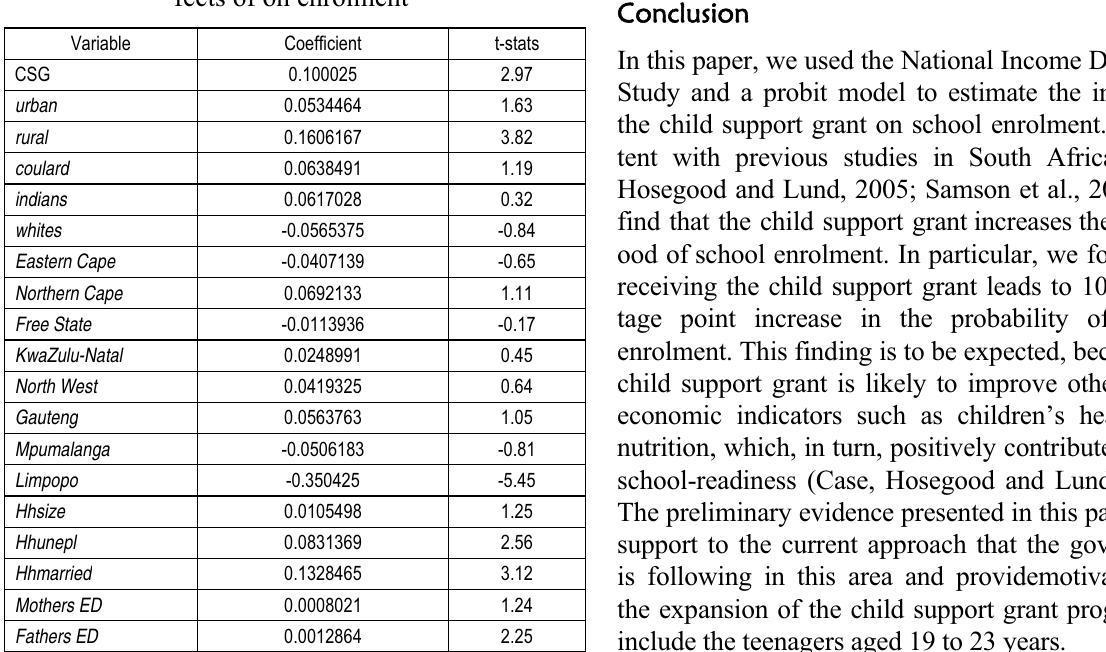
Table 1. Probit estimates of child support grant